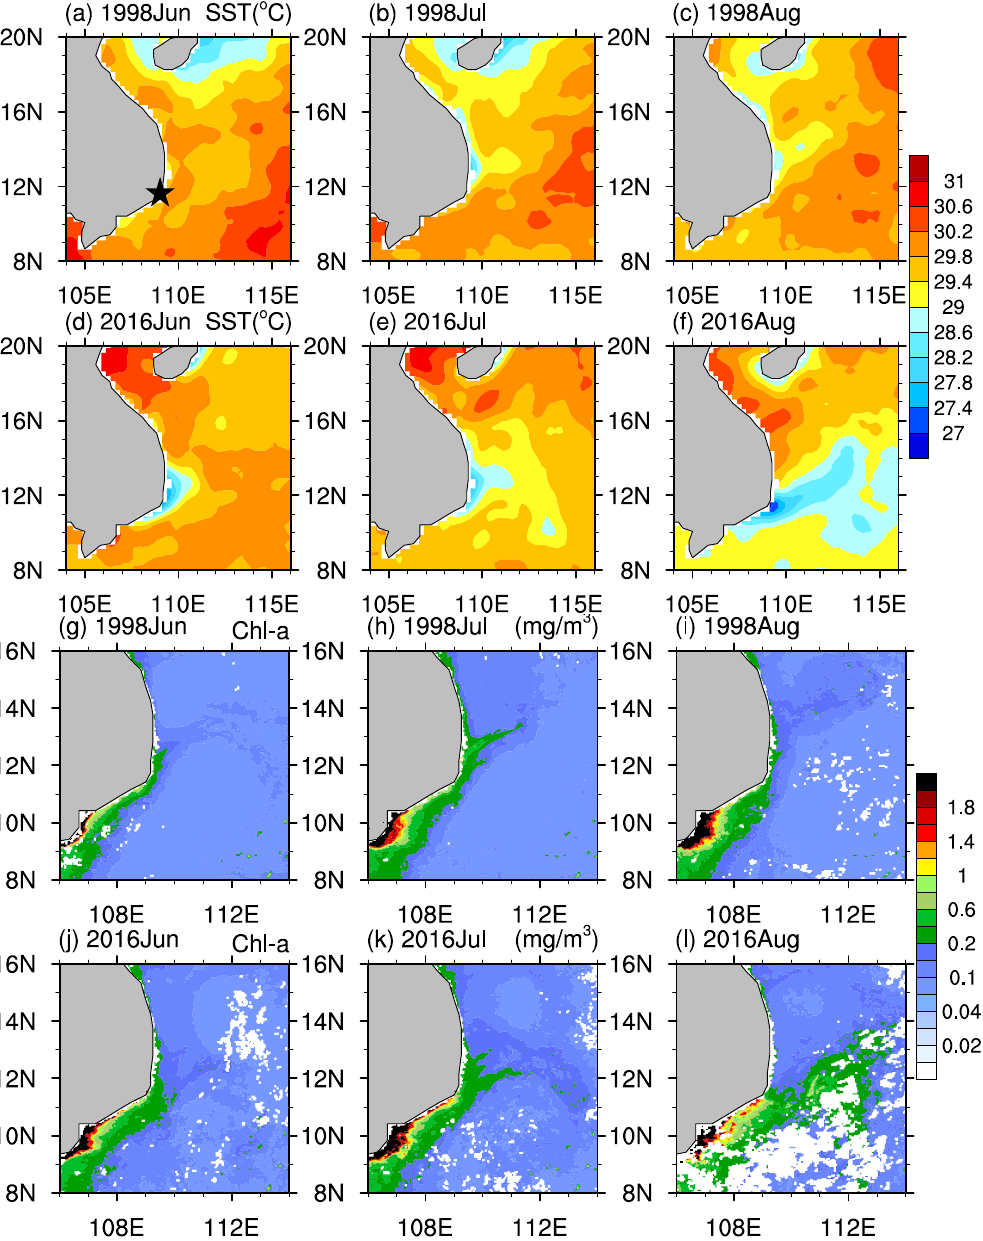
Figure 2. Spatial distribution of monthly sea surface temperature (SST) (units: °C) in 1998. ( a )–( c ) Correspond to June to August. ( d )–( f ) Same as in ( a )–( d ) but for the results in 2016. ( g )–( i ) Same as in ( a )–( c ) but for the results of the spatial distribution of monthly Chl-a concentration (units: mg/m 3 ). ( j )–( l )Same as in ( g )–( i ) but for the results in 2016.